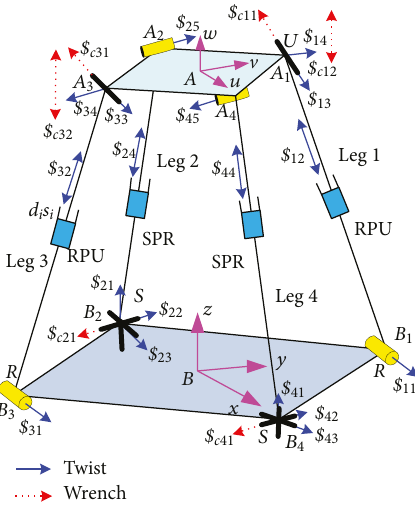
Figure 2: Schematic diagram of the redundantly actuated parallel